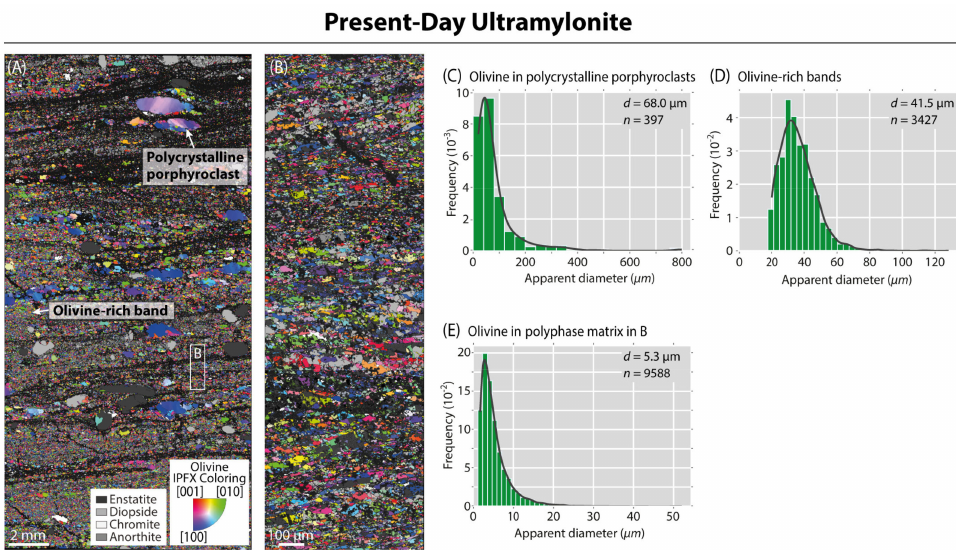
Figure 5. Microstructure results from the present-day ultramylonite. ( A ) Combined EBSD phase and inverse pole figure (IPF) map illustrating the microstructure of the polyphase band. The inverse pole figure map of olivine crystallographic axis orientation is colored relative to the lineation, which is parallel to the upper edge of the map (IPF-X coloring). Black lines correspond to grain boundaries. Black areas correspond to zero solutions (not-indexed domains). Step size is 8 µ m. ( B ) Detail of the map in ( A ). Step size is 0.7 µ m. ( C – E ) Frequency distributions of olivine grain size for olivine in polycrystalline porphyroclasts ( C ), fine-grained olivine rich bands in the polyphase matrix ( D ), and olivine in the polyphase matrix ( E